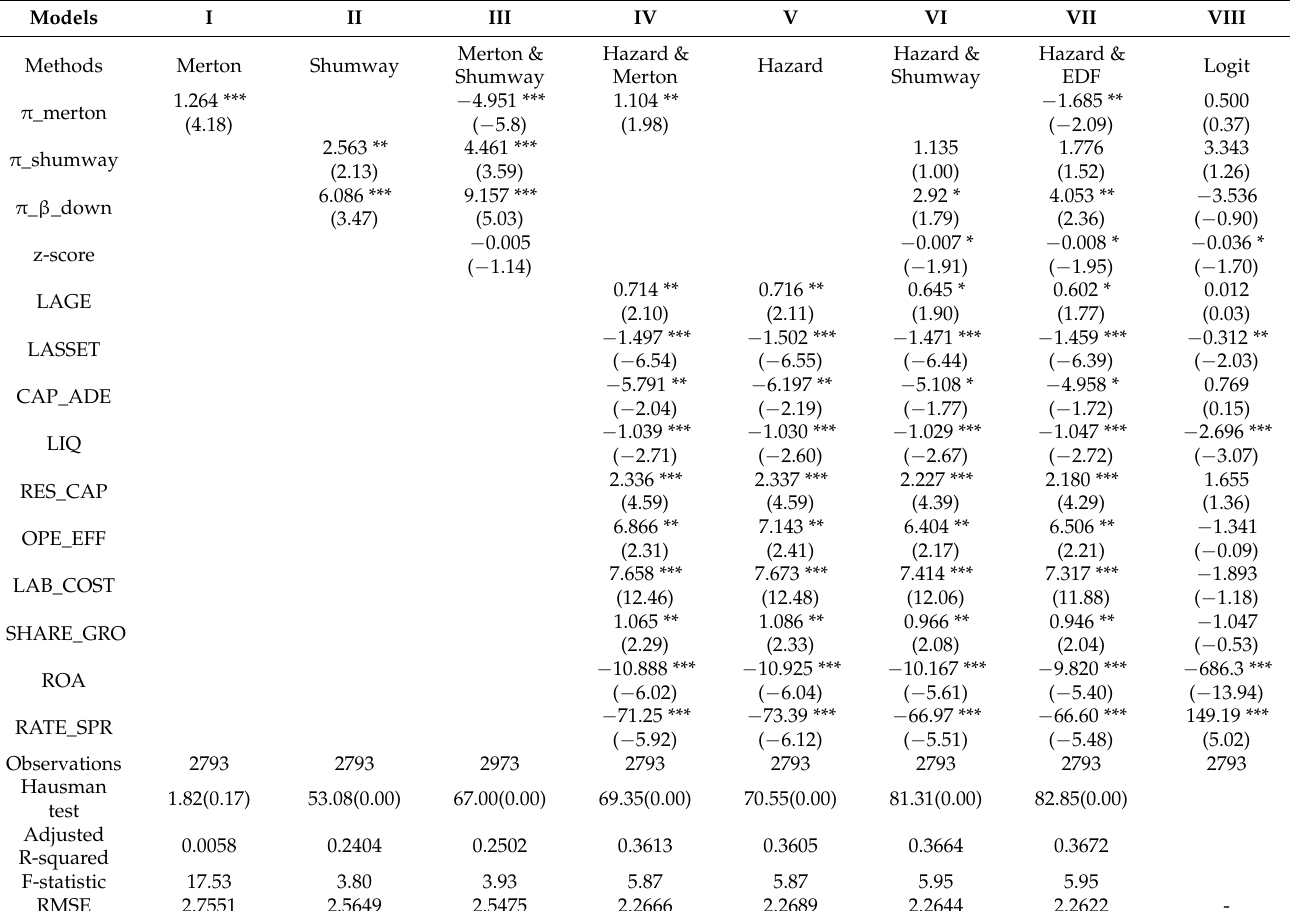
Table 7. Models’ estimation results and